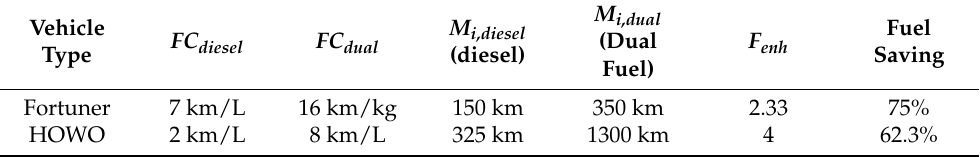
Table 3. Technical performance of diesel-CNG-fueled medium-duty and heavy-duty